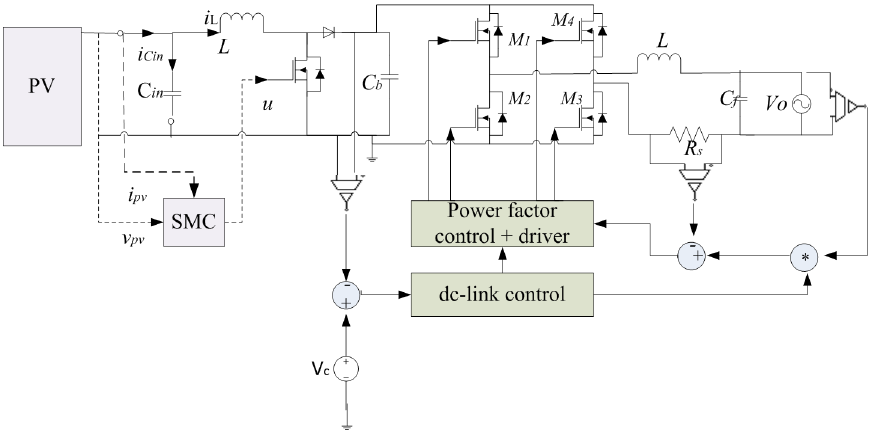
Figure 15. Circuital scheme of the detailed grid-connected PV system.